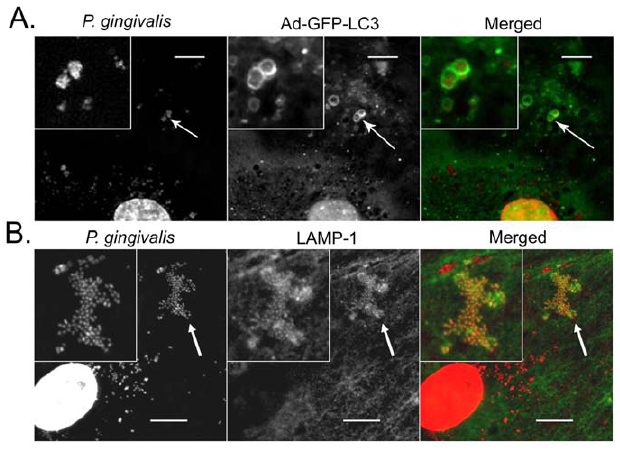
Figure 4. Representative microscopic images of P.gingivalis strain W83 within LC3 positive or LAMP-1 positive vacuoles at 6 hours post-inoculation. Arrows indicate magnified inserts. Scale bar is equivalent to 10 m m. Representative images of other P. gingivalis strains can be viewed in supporting file Figure S4.